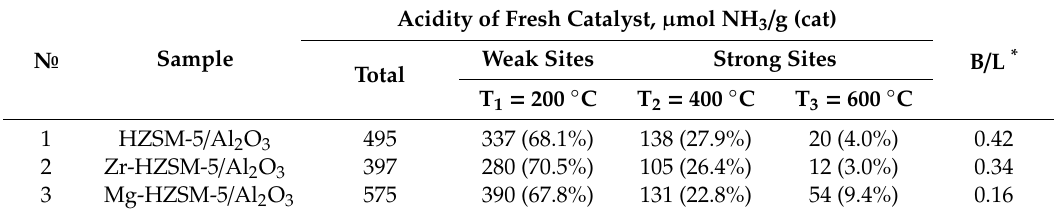
Table 3. Acidic properties of HZSM-5/Al 2 O 3 , Zr-, and Mg- modified samples